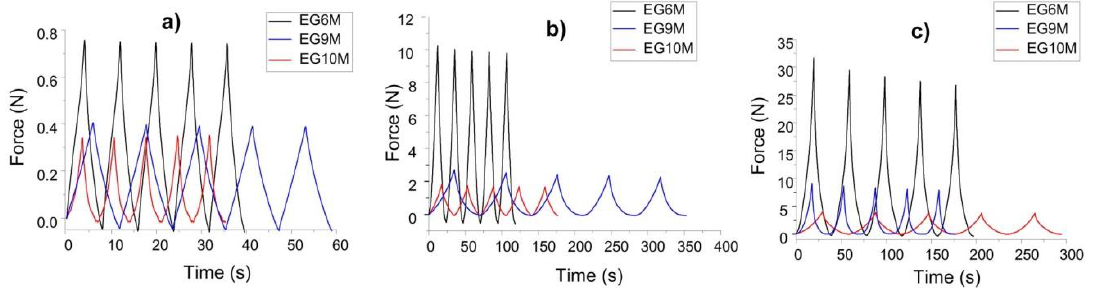
Figure 10. Compression tests of the monoliths at different compressive strains: ( a ) 10%, ( b ) 30%, and ( c ) 50%. ( c ) 50%.